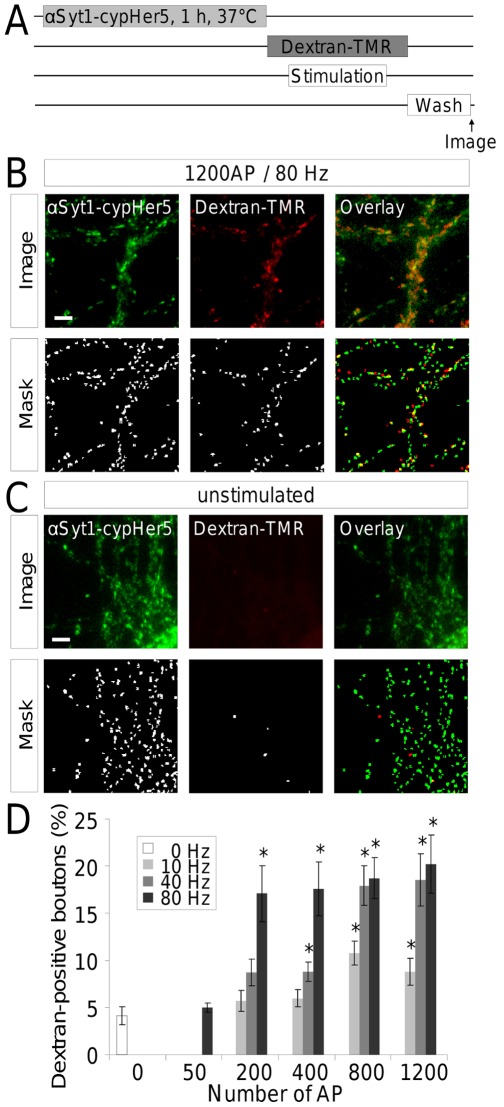
The initiation of ADBE depends on the frequency rather than the number of AP.(A) Experimental procedure. Functional synapses of rat hippocampal neurons were fluorescently labelled with anti-synaptotagmin1-cypHer5 (αSyt1-cypHer5) which fluoresces due to the acidic pH in the acidic vesicular lumen after endocytosis. The cells were then electrically stimulated with varying intensities (see panel (D)) in the presence of 50 µM dextran-TMR, which serves as a marker for bulk membrane invaginations. (B) Representative images of αSyt1-cypHer5 antibody-stained hippocampal neurons that were stimulated with 1200 AP, 80 Hz in the presence of dextran-TMR (“image”). Quantification of dextran-positive terminals was done by a Laplace operator based peak-detection (“mask”) followed by colocalization analysis. (C) Representative images of αSyt1-cypHer5 antibody-stained hippocampal neurons that were exposed to dextran-TMR without electrical stimulation. Automatically detected regions of interest are indicated in the lower panel. (D) Dextran-TMR positive boutons indicating terminals with bulk endosomes were quantified for varying numbers of action potentials (50, 200, 400, 800, 1200) and varying frequencies (10, 40, 80 Hz) of electrical stimulation. N = 3 to 4 experiments with 3 to 6 fields of view each; error bars represent SEM; One-way ANOVA for groups of constant numbers of AP and varying Hz: 200 AP: p<0.05; 400 AP: p>0.05; 800 AP: p<0.05; 1200 AP: p<0.01; Post-hoc test: Dunnett’s test. Asterisks indicate significant differences to unstimulated control at the 5% probability level for a 15 group comparison with a group size of 12 (critical value 2.87).